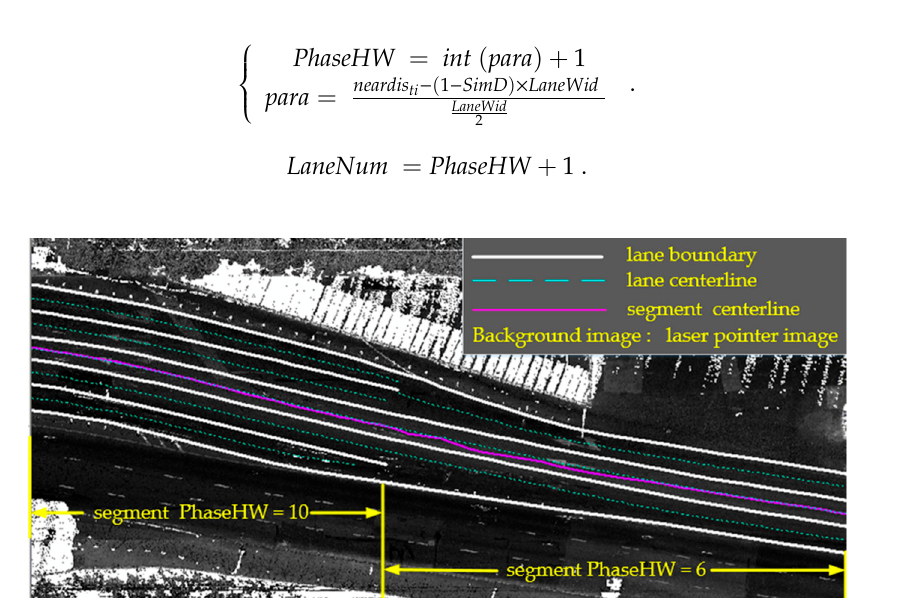
Figure 3. Example of the PhaseHW (the number of half lane width metrics) of a real world segment.